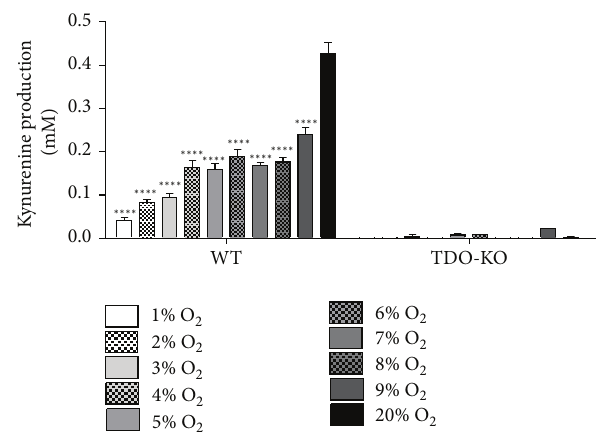
Figure 7: Loss of TDO activity in liver homogenates under hypoxic conditions. Determination of murine TDO ex vivo activity. Livers of WT or TDO-deficient C57BL/6 mice were homogenized in PBS and liverhomogenisateswereaddedtoTDO-bufferin48-wellmicrotiter plates, followed by an incubation under normoxia (20% O 2 ) or other oxygen amounts (1–9% O 2 ) for 4 h at 37 ∘ C. Then the reaction was stopped using 30% trichloroacetic acid and the kynurenine amount was determined in the supernatants via supplementation of Ehrlich’s reagent and absorbance at 492 nm. 𝑛 = 3 independent experiments with three replicates each. A significant alteration of kynurenine levels as compared to the normoxia control is marked with asterisks ( ∗∗∗∗ 𝑝 ≤ 0.0001 ), as determined via a two-tailed, unpaired t -test. The bars indicate the mean value ±